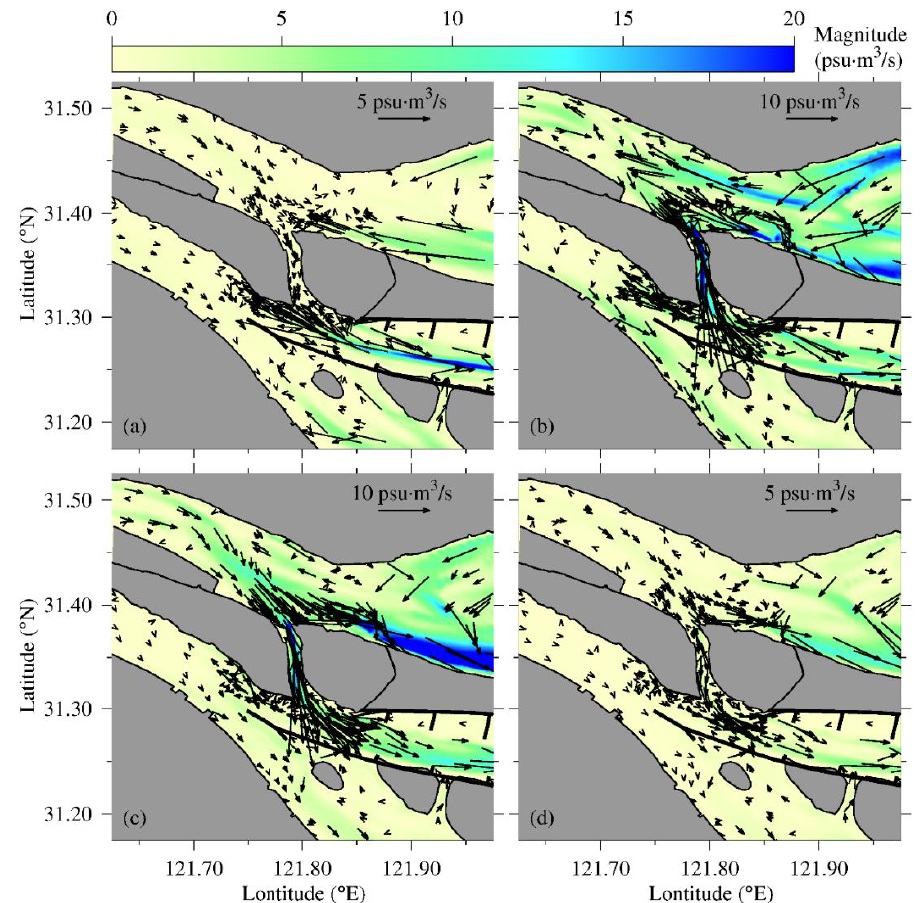
Figure 15. Residual salt transport distributions during neap tide ( a ), middle tide after neap tide ( b ), spring tide ( c ) and middle tide after spring tide ( d ) in EX2.